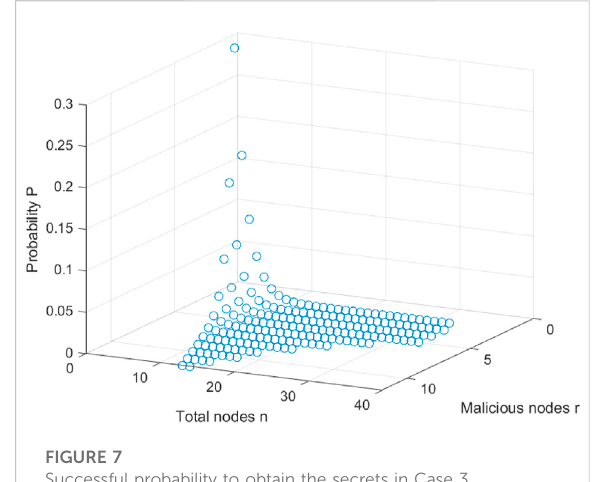
FIGURE 6 Successful probability to obtain the secrets in Case 2.